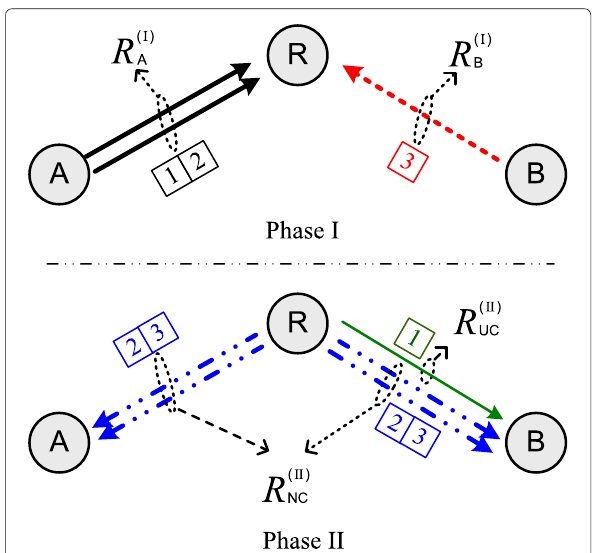
Fig. 1 The illustration of the proposed joint resource allocation and network coding transmission scheme for two-way relay OFDM network, where different line styles present different sets of subcarriers. In the source phase, A and B are assigned different subcarriers, and they transmit their information to R via their assigned subcarriers simultaneously, and in the relay phase, system subcarriers are assigned to the network coded flow and uncode flow, then the two flows are forwarded by R over their assigned subcarriers simultaneously